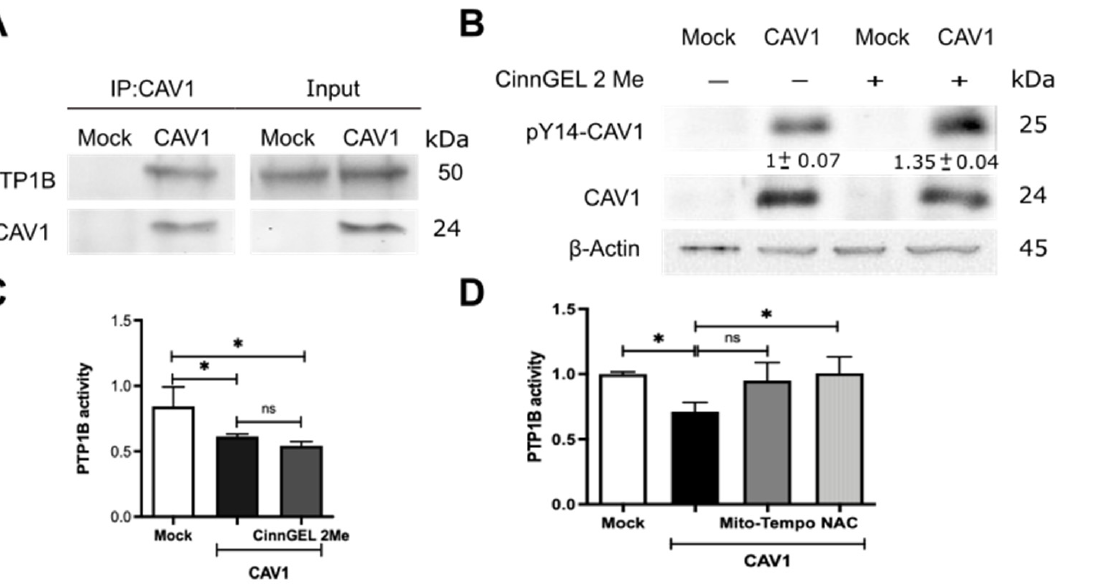
Figure 6. Inhibition of PTP1B activity enhances cell migration, invasion, and lactate production by increasing CAV1 phosphorylation. ( A ) CAV1 was immunoprecipitated from protein extracts con- taining 2 mg of total protein obtained from B16F10(Mock) and B16F10(CAV1) cells using a polyclo- nal antibody against CAV1 (2.5 μ g per condition). An immunoblot with the total protein input in each experiment is included in the panel to the right. ( B ) B16F10(Mock) and (CAV1) were treated for 12 h with 5 μ mol/L CinnGEL 2Me. Total protein extracts were prepared and analyzed by West- ern blotting with antibodies against CAV1, pY14-CAV1, and β -actin. Western blots representative